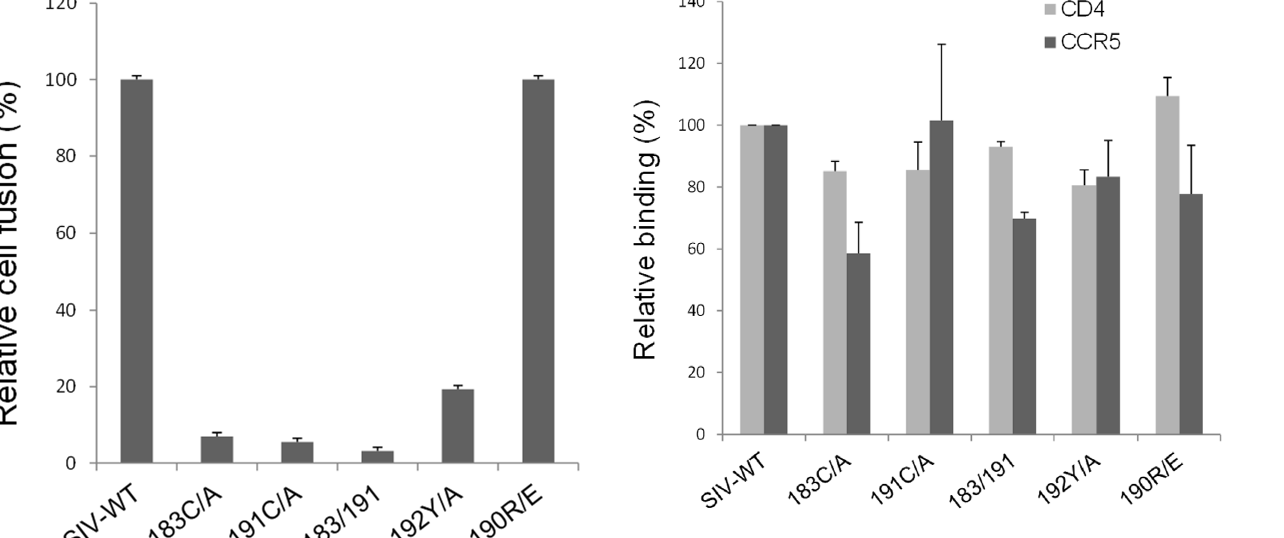
Figure 4. Receptor binding of SIVmac239 Env variants. The assay measuring gp120 binding to human CD4 and human CCR5 utilized 35 S-radiolabeled gp120 precipitated with CD4-Ig or incubated with CCR5-expressing cells in the presence of soluble